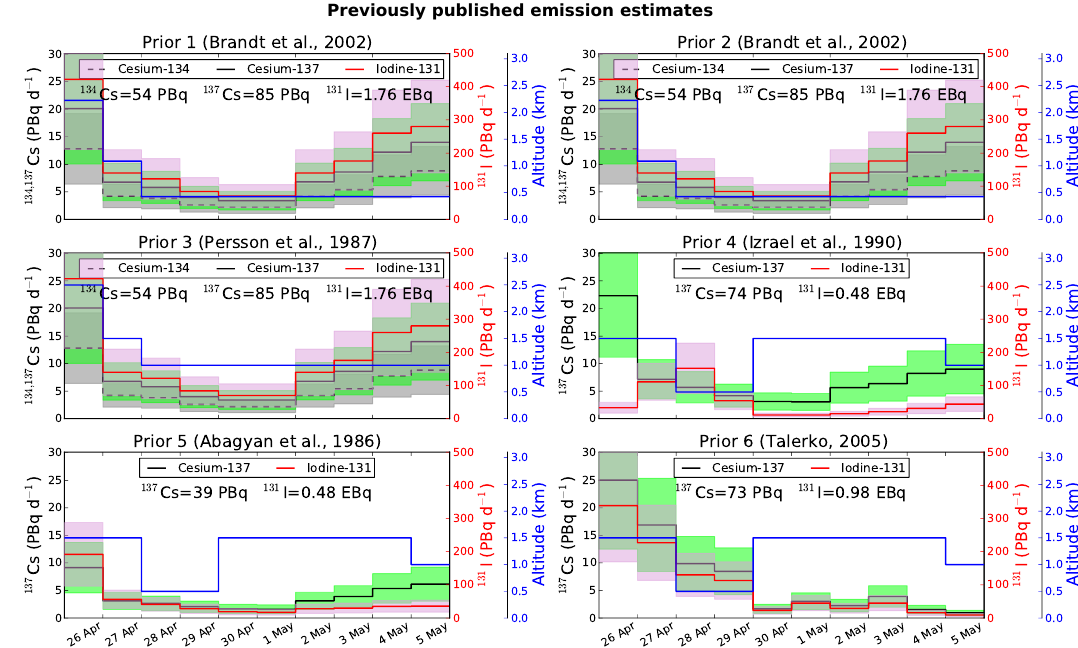
Figure 1. Six different profiles of source releases for 134 Cs (black dashed line), 137 Cs (black line) and 131 I (red line), published after the Chernobyl accident. These emissions were used to calculate the a priori (prior) source information and the relative uncertainty of the inversion. Blue line indicates the maximum altitude of the